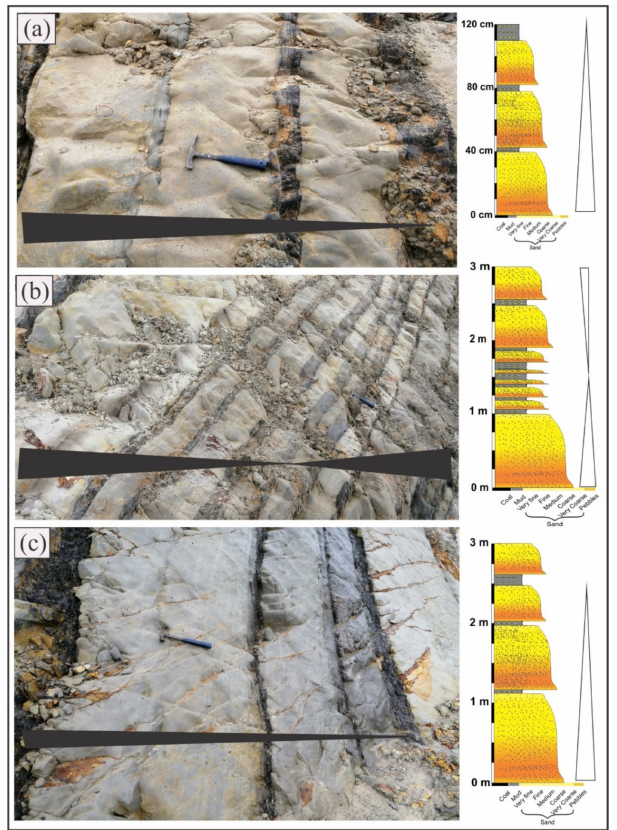
Figure 8. Thinning and thickening cycles in the Jalan UMS road section, where the vertical thicknesses of the cyclic patterns ranged only from 1.2 to 2.7 m, which is indicative of a bed set or a lobe element. ( a ) Thinning pattern interpreted to be a lobe element. ( b ) Thinning and then thickening sequence, where each pattern represents the geometry of an individual lobe element. ( c ) Thinning trend with a vertical thickness of about 2.6 m in the set of